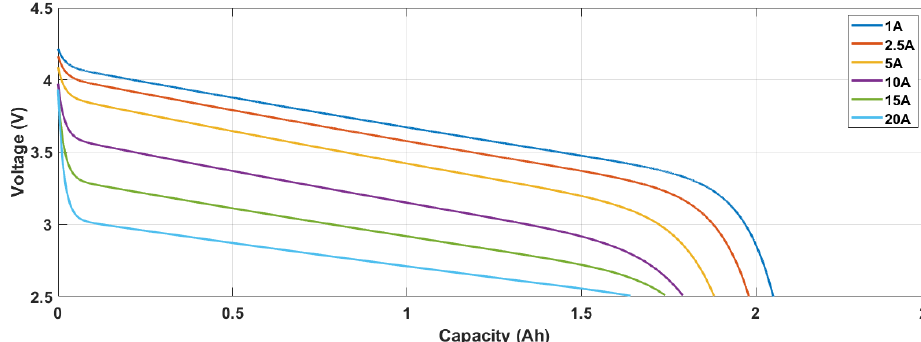
Figure 11. Discharge characteristics for SoH = 79%.